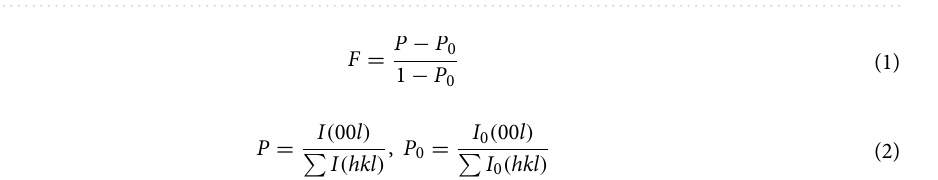
Figure 3. SEM images of ( a ) Bi, ( b ) Te and ( c ) Se raw powders. Cross-section SEM images of ( d ) Bi 2 Te 3 compound synthesized by FS, ( e ) Bi 2 Te 2.7 Se 0.3 compound synthesized by FS, ( f ) Bi 2 Te 3 sample further prepared by SPS at 723 K for 3 min, ( g ) Bi 2 Te 3 sample further prepared by SPS at 753 K for 2 min, ( h ) Bi 2 Te 3 sample further prepared by SPS at 753 K for 3 min, ( i ) Bi 2 Te 2.7 Se 0.3 sample further prepared by SPS at 753 K for 3 min. The insets show the EDS